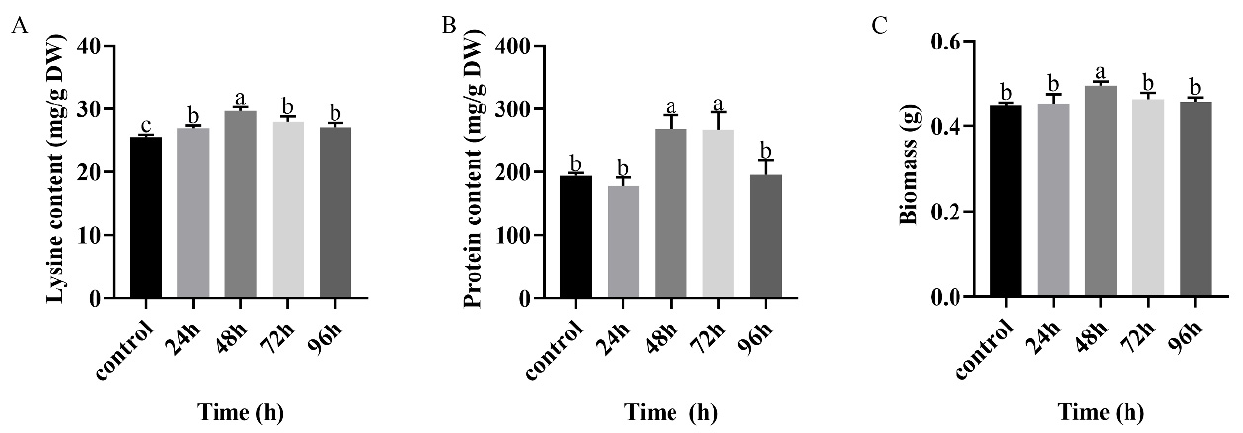
Figure 2. Effects of chitosan treatment of different durations on ( A ) lysine, ( B ) protein and ( C ) biomass of F. filiformis mycelium. All the calculated results are expressed in the form of mean ± standard deviation, while different English letters indicate significant differences among different treatments ( p < 0.05).